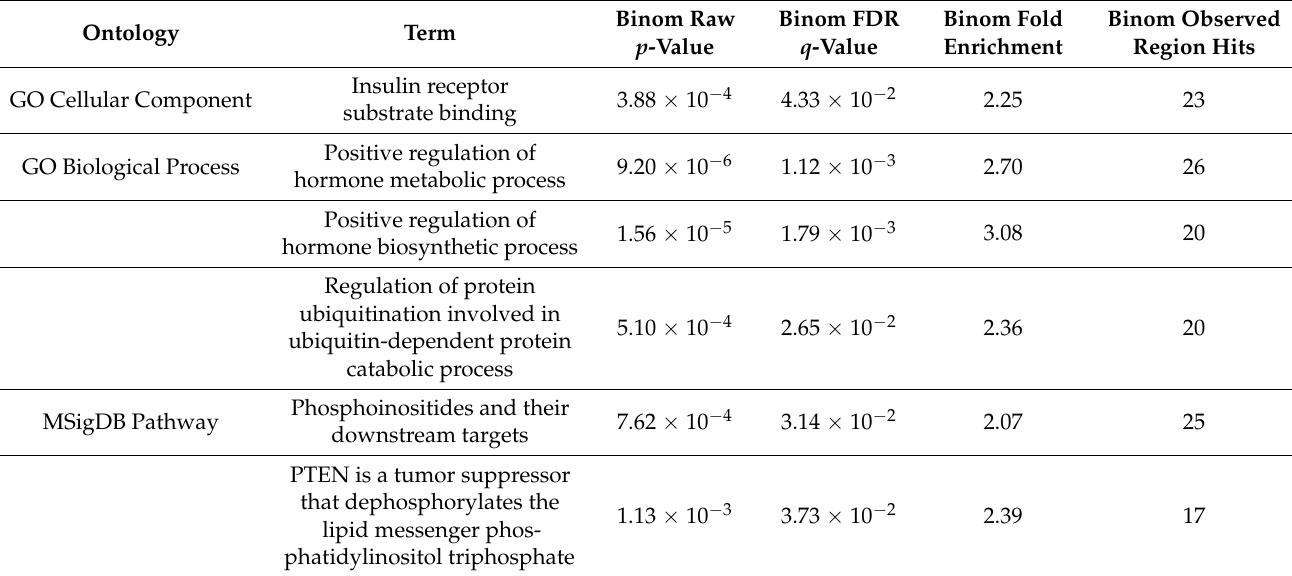
Table 2. Enrichment of gene ontologies and pathways among DMPs with p < 0.01.